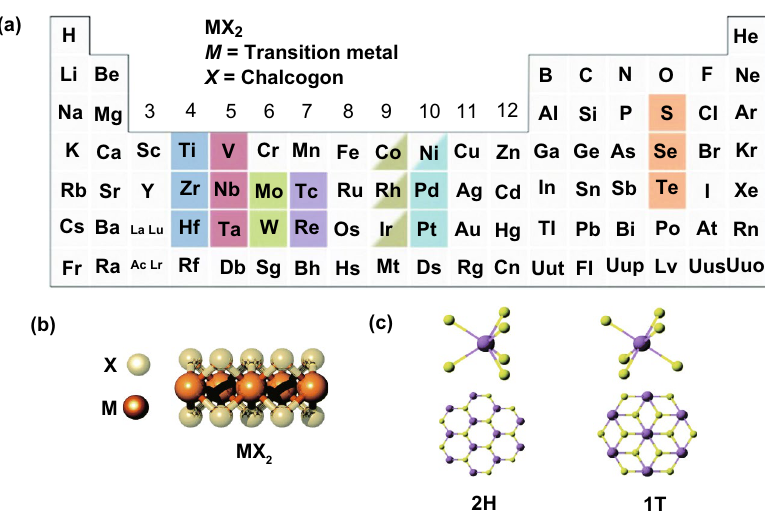
Fig. 5 a Transition metals and three chalcogen elements (yellow color) which are composed of TMD layer structures. b TMD structures. c MoS 2 two‑phase (1T, 2H) structures. Adapted with permission from Ref.